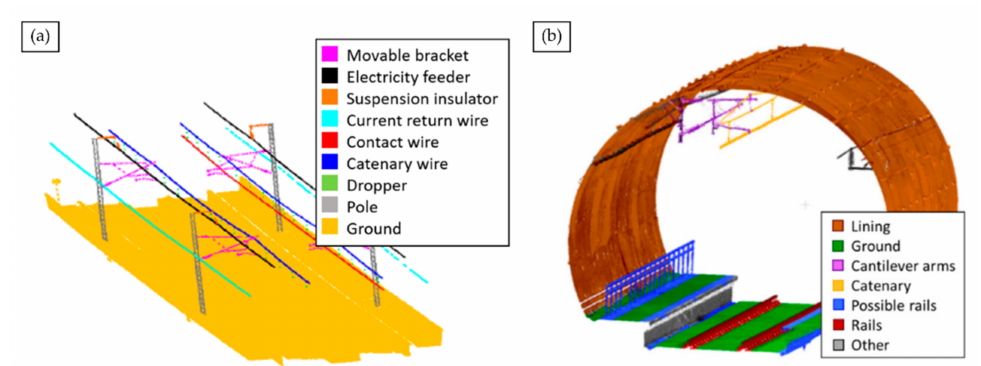
Figure 9. BIM for RTI. ‘As-is’ BIMs [181] frequently adopt LiDAR point cloud segmentation (via RANSAC and Supported Vector Machine methods) to label trackside assets both ( a ) outside and ( b ) within the tunnel environment